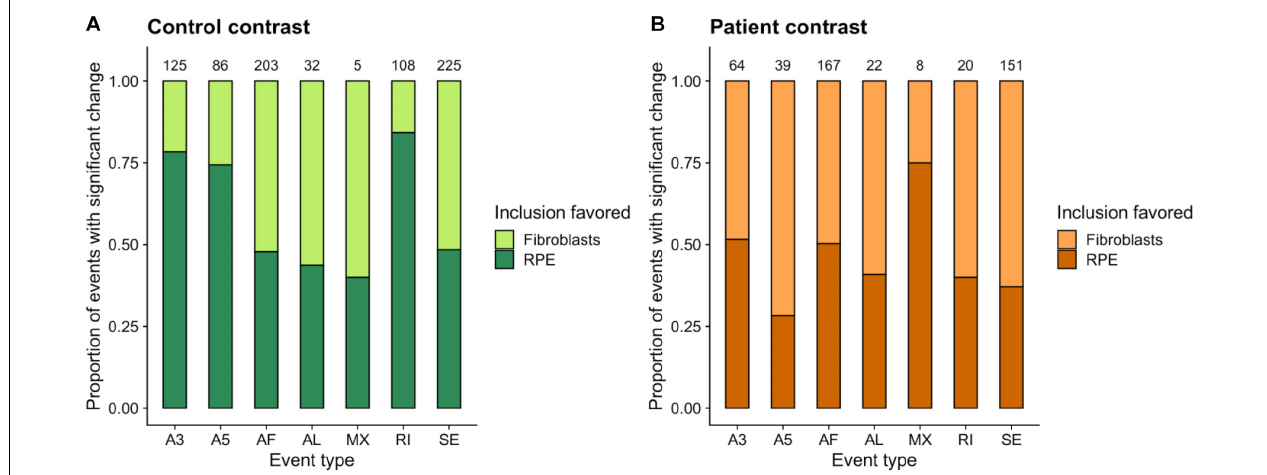
FIGURE 6 | Summary of unique alternatively spliced events ( p value < 0.05) detected in the control (A , Control-fibroblasts vs. Control-RPE ) and patient (B , Patient-fibroblasts vs. Patient-RPE ) contrasts. The proportion of events for which inclusion is favored in each clinical condition is indicated by bar area. The number of events for each category is shown in the label above the bar. Event types: A3, Alternative 3 (cid:48) site; A5, Alternative 5 (cid:48) site; AF, Alternative First exon; AL, Alternative Last exon; MX, Mutually Exclusive Exons; RI, Retained Intron; SE, Skipped Exon.